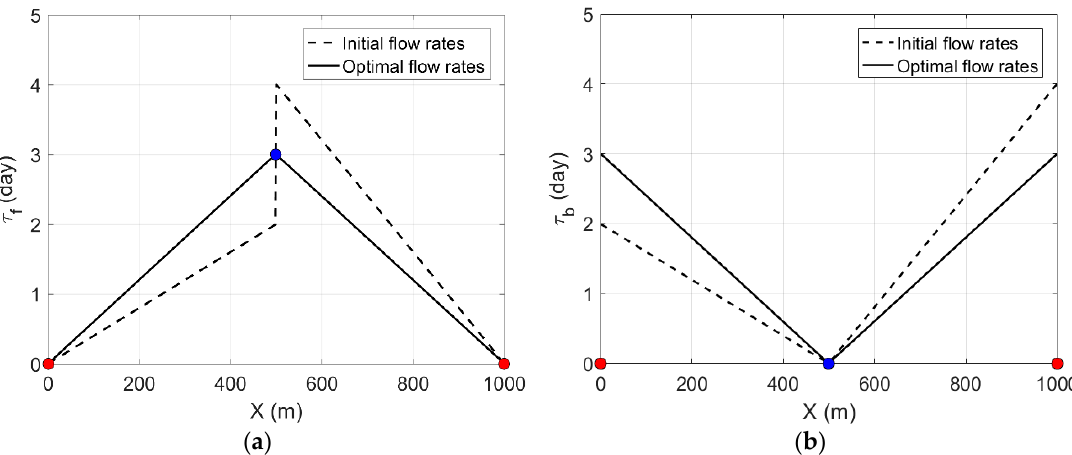
Figure 3. The results of the one-dimensional test problem: ( a ) forward and ( b ) backward travel time distributions for the initial and optimal designs involving flow rate optimization.